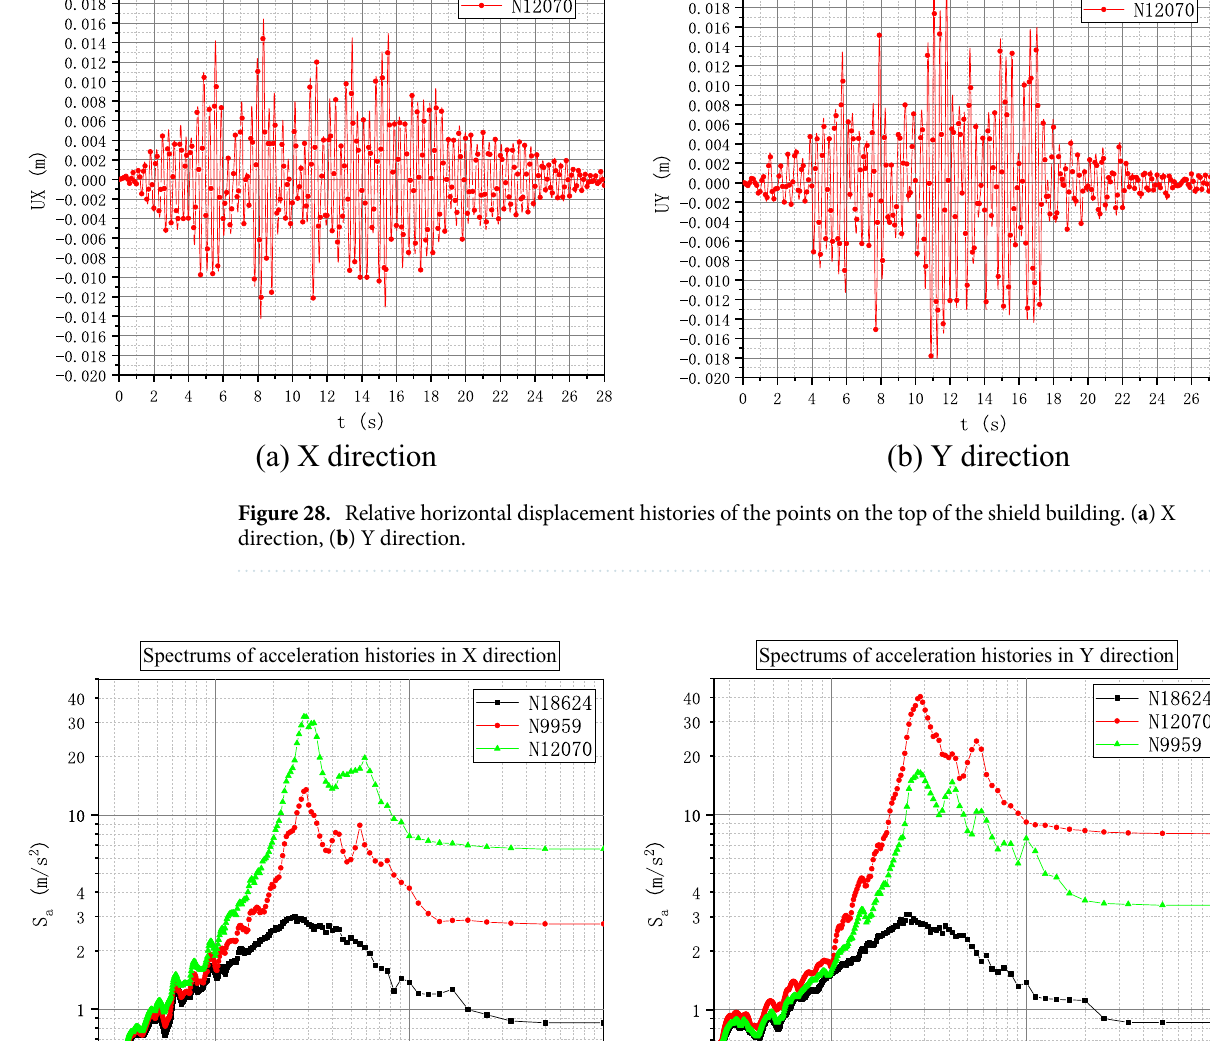
Figure 29. Floor response spectrums of monitoring points at different heights (33.576 m, 69.671 m, 116.916